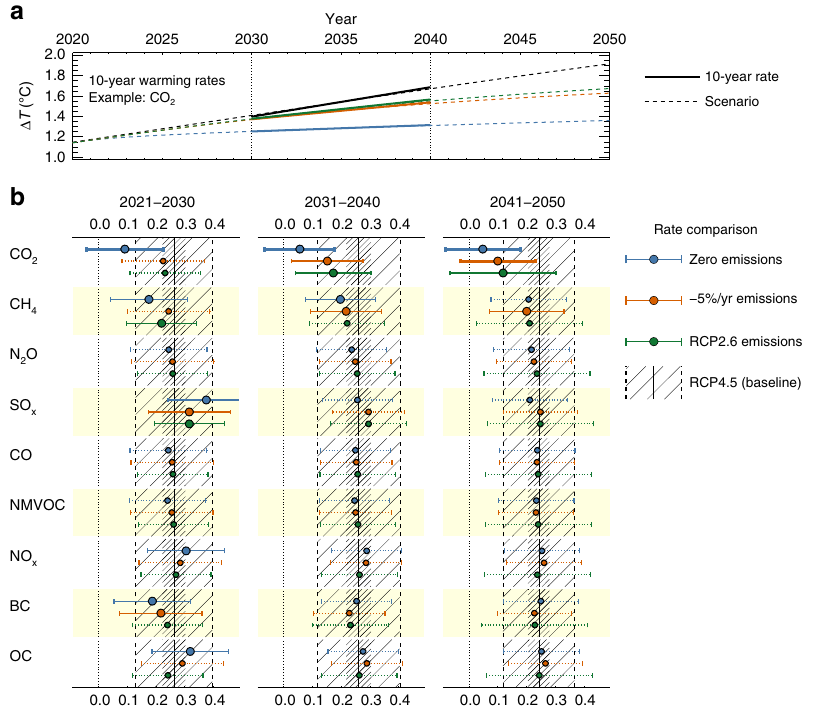
Fig. 4 The impact of single component mitigation on rates of warming. a Example calculation for the CO 2 mitigation scenarios (dashed lines). The solid lines show the 10-year average trends for 2031-2040. b Warming rates for three coming decades (columns), for each component and scenario (colored bar-and-whiskers), compared to RCP4.5 (black lines and hatching). Projections calculated with MAGICC6, internal variability is taken from CESM1 LENS (32 ensemble members). Dots and whiskers show the mean and ±1 standard deviation of the rates in the mitigated scenarios. Solid lines indicate where the mean trend is outside a third of the standard deviation of trends from LENS evolution added to RCP4.5 (dense hatching). Large symbols and fat lines show when the trend is outside one standard deviation in RCP4.5 (open hatching).